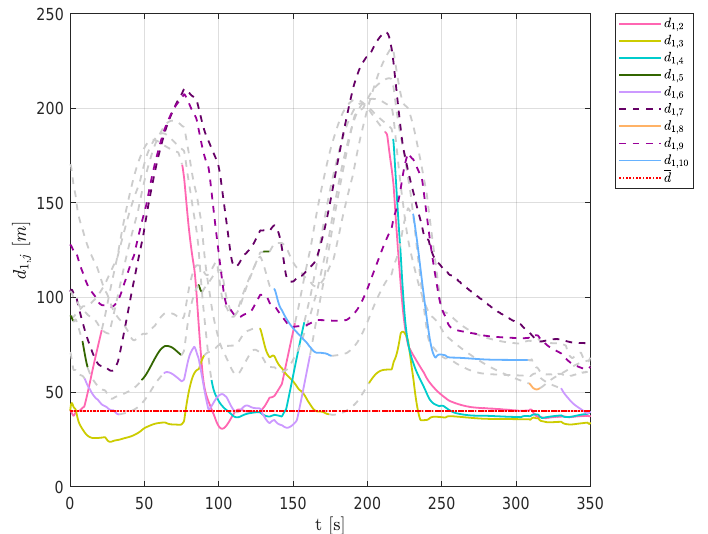
Figure 22. Scenario #2—10 aircraft: distances between UAV 1 and the other swarm vehicles. Solid lines are used for visible aircraft and dashed gray lines are employed whenever they are no longer visible, whereas dashed colored lines are used for never-visible UAVs. The desired distance is highlighted using a dotted red line.